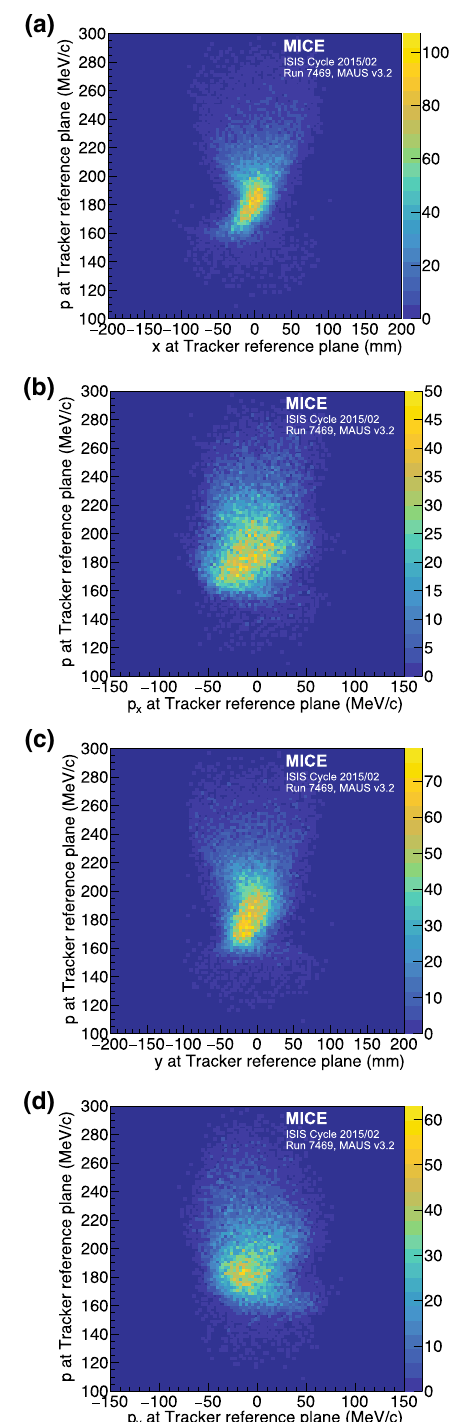
Fig. 7 The effect of dispersion, the dependence of the components of transverse phase space on the momentum, p , is shown at the reference surface of the upstream tracker: a ) ( x , p ) ; b ( p x , p ) ; c ( y , p ) ; d ( p y , p )